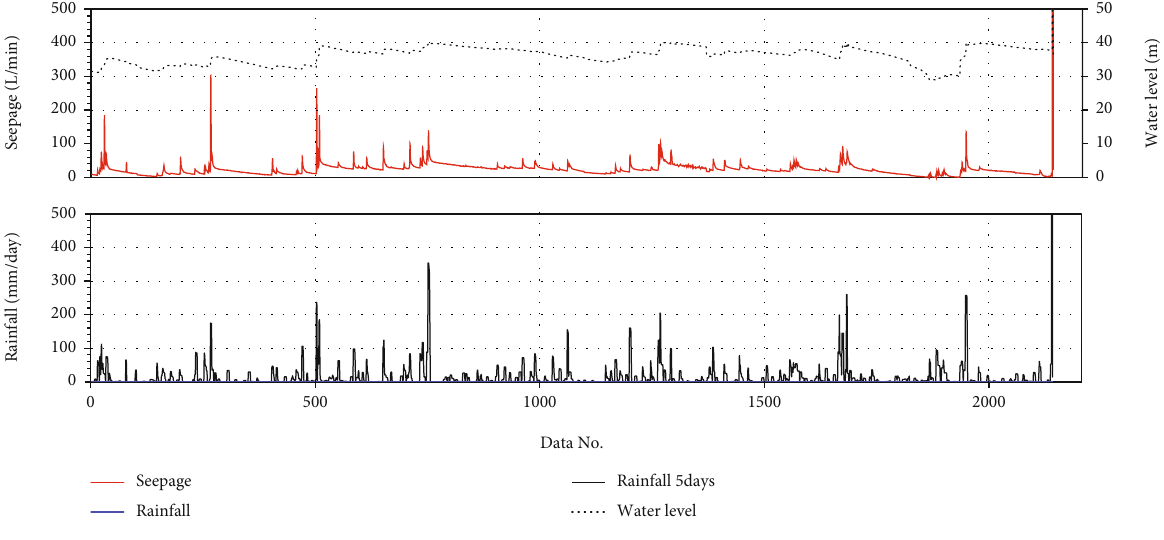
Figure 10: Seepage, rainfall, and water level for group A.